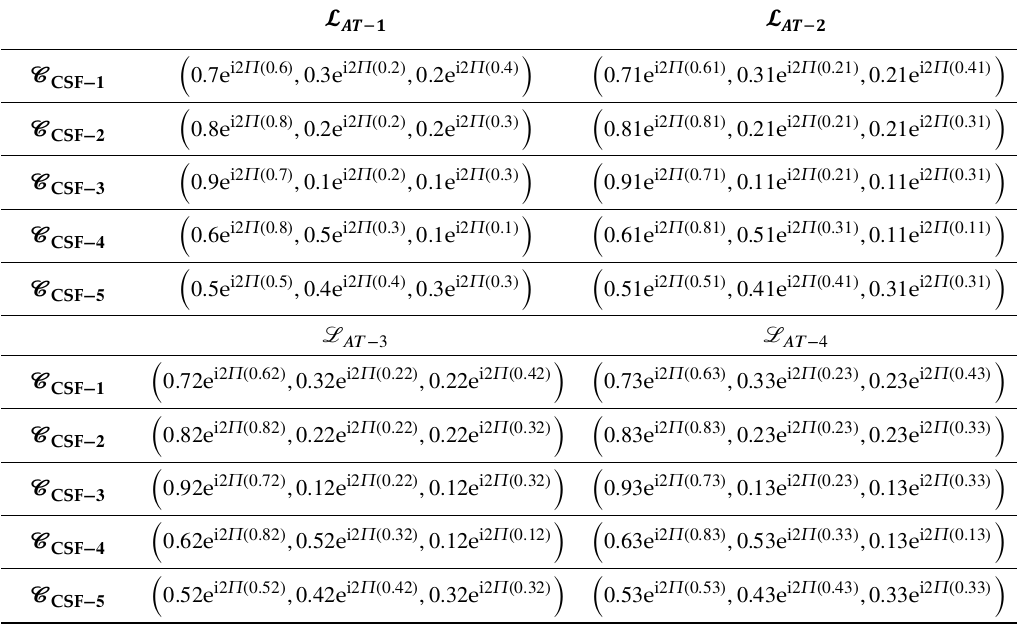
Table 1. Decision matrix.